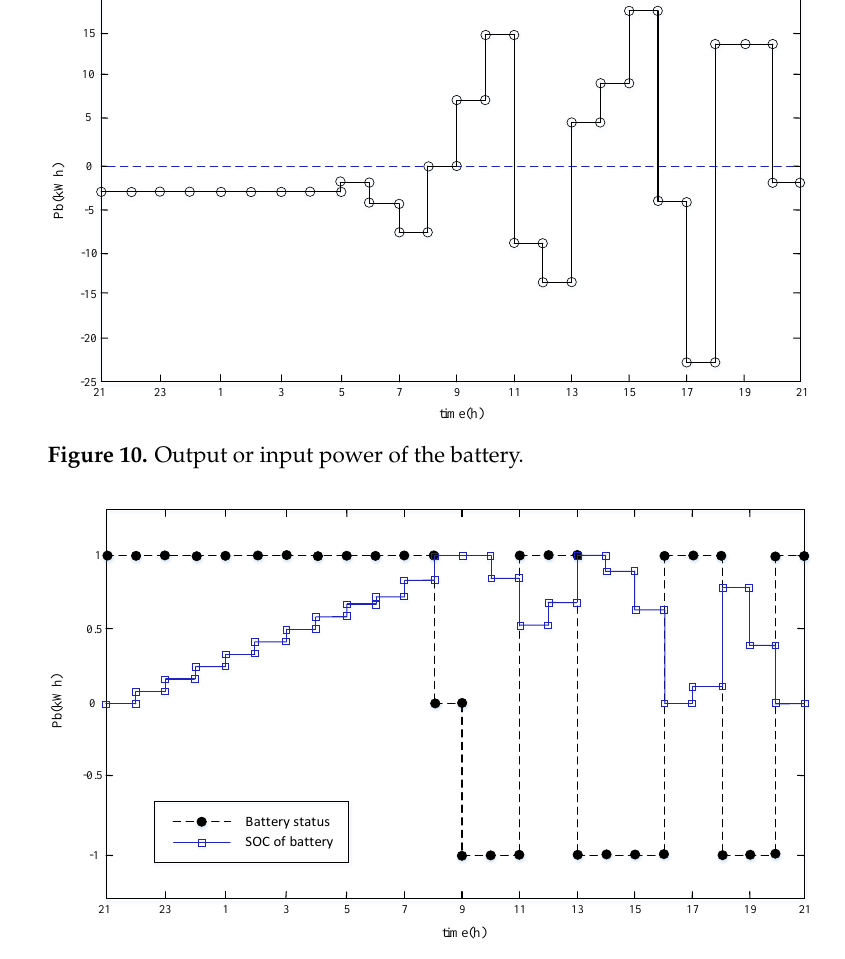
Figure 11. The SOC of the battery. The heat load requirements and their grey domain values are shown in Figure 12.